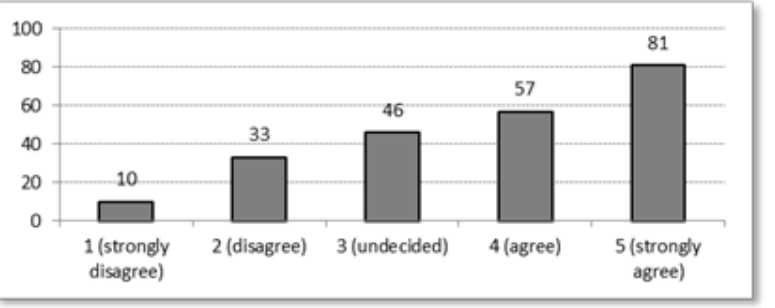
Figure 13. Degree of agreement with the following statement: “reduced costs and less travel are advantages of e-learning” (absolute numbers). Valid answers: 227.